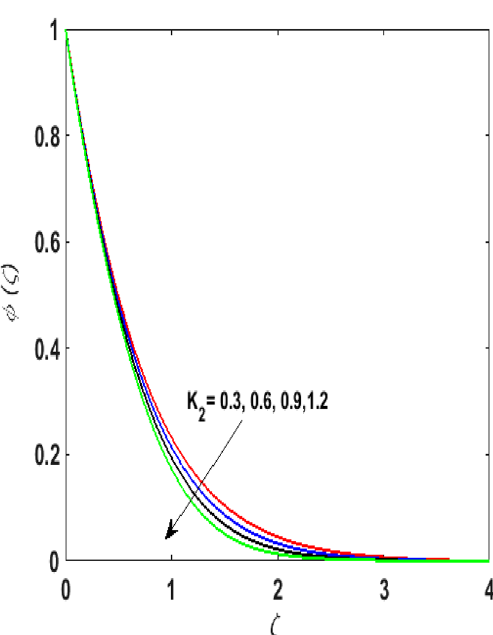
Figure 17. φ(ζ) for various K 2